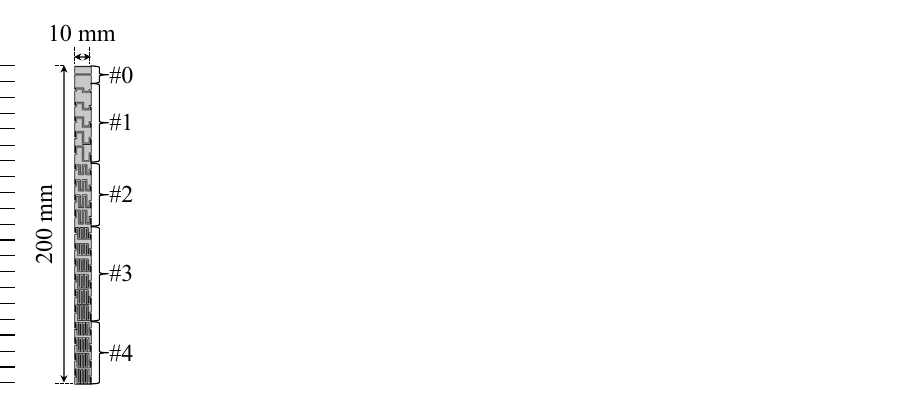
Figure 4. Designed acoustic metasurface for refracting normal incident plane waves with the angle of 20 degrees. The size is a × ∆ d = 200 × 10 mm 2 . A 1D straight acoustic waveguide structure ( w = 0.8 mm and l = ∆ d = 10 mm) is adopted to #0. The structures of #1–#4 in Figure 2 correspond to #1–#4 in this figure and the calculated waveguide lengths in Figure 3 are used for these.